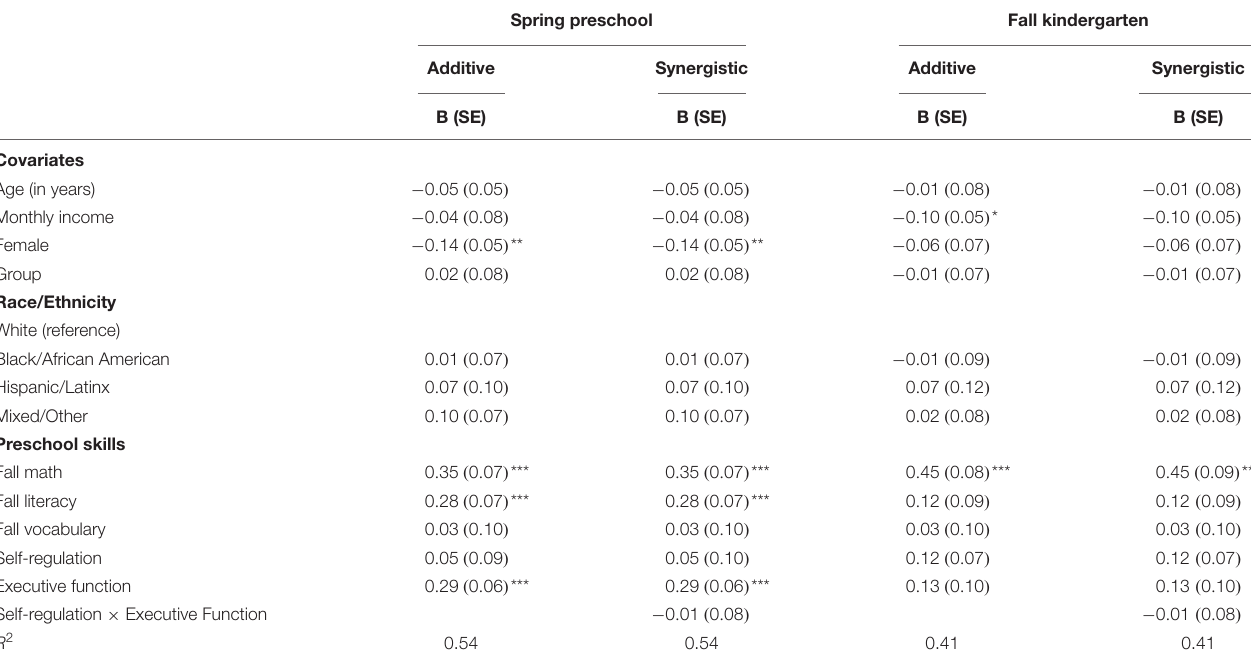
TABLE 3 | Model estimates for additive and synergistic effects of preschool self-regulation and executive function on math outcomes. Spring preschool Fall kindergarten Additive Synergistic Additive